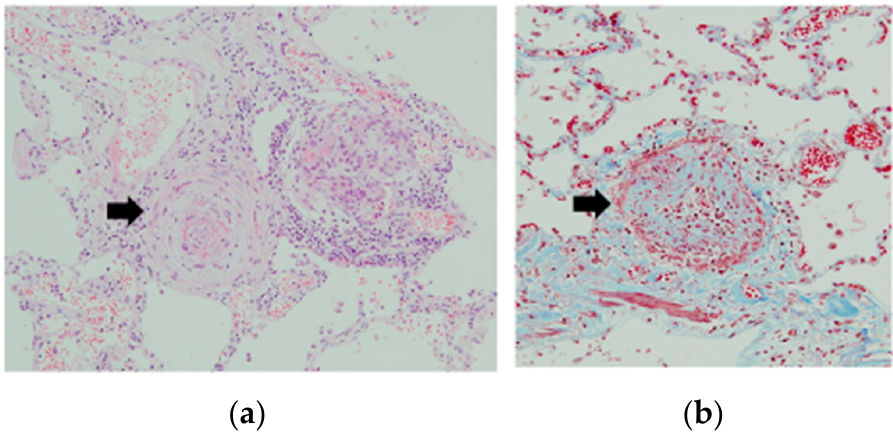
Figure 1. Autopsy of PoPH patient #1. Hematoxylin-eosin stain ( a ) and Masson trichrome staining ( b ). Typical histology of pulmonary arteries (PA). Severe sclerosis of pulmonary arteries. ( a ) Hypertrophy of the internal membrane of the small pulmonary arteries and narrow lumen, compatible with severe pulmonary arterial hypertension. ( b ) Proliferation of the elastic fibers was found in the pulmonary arteries using Masson trichrome staining.